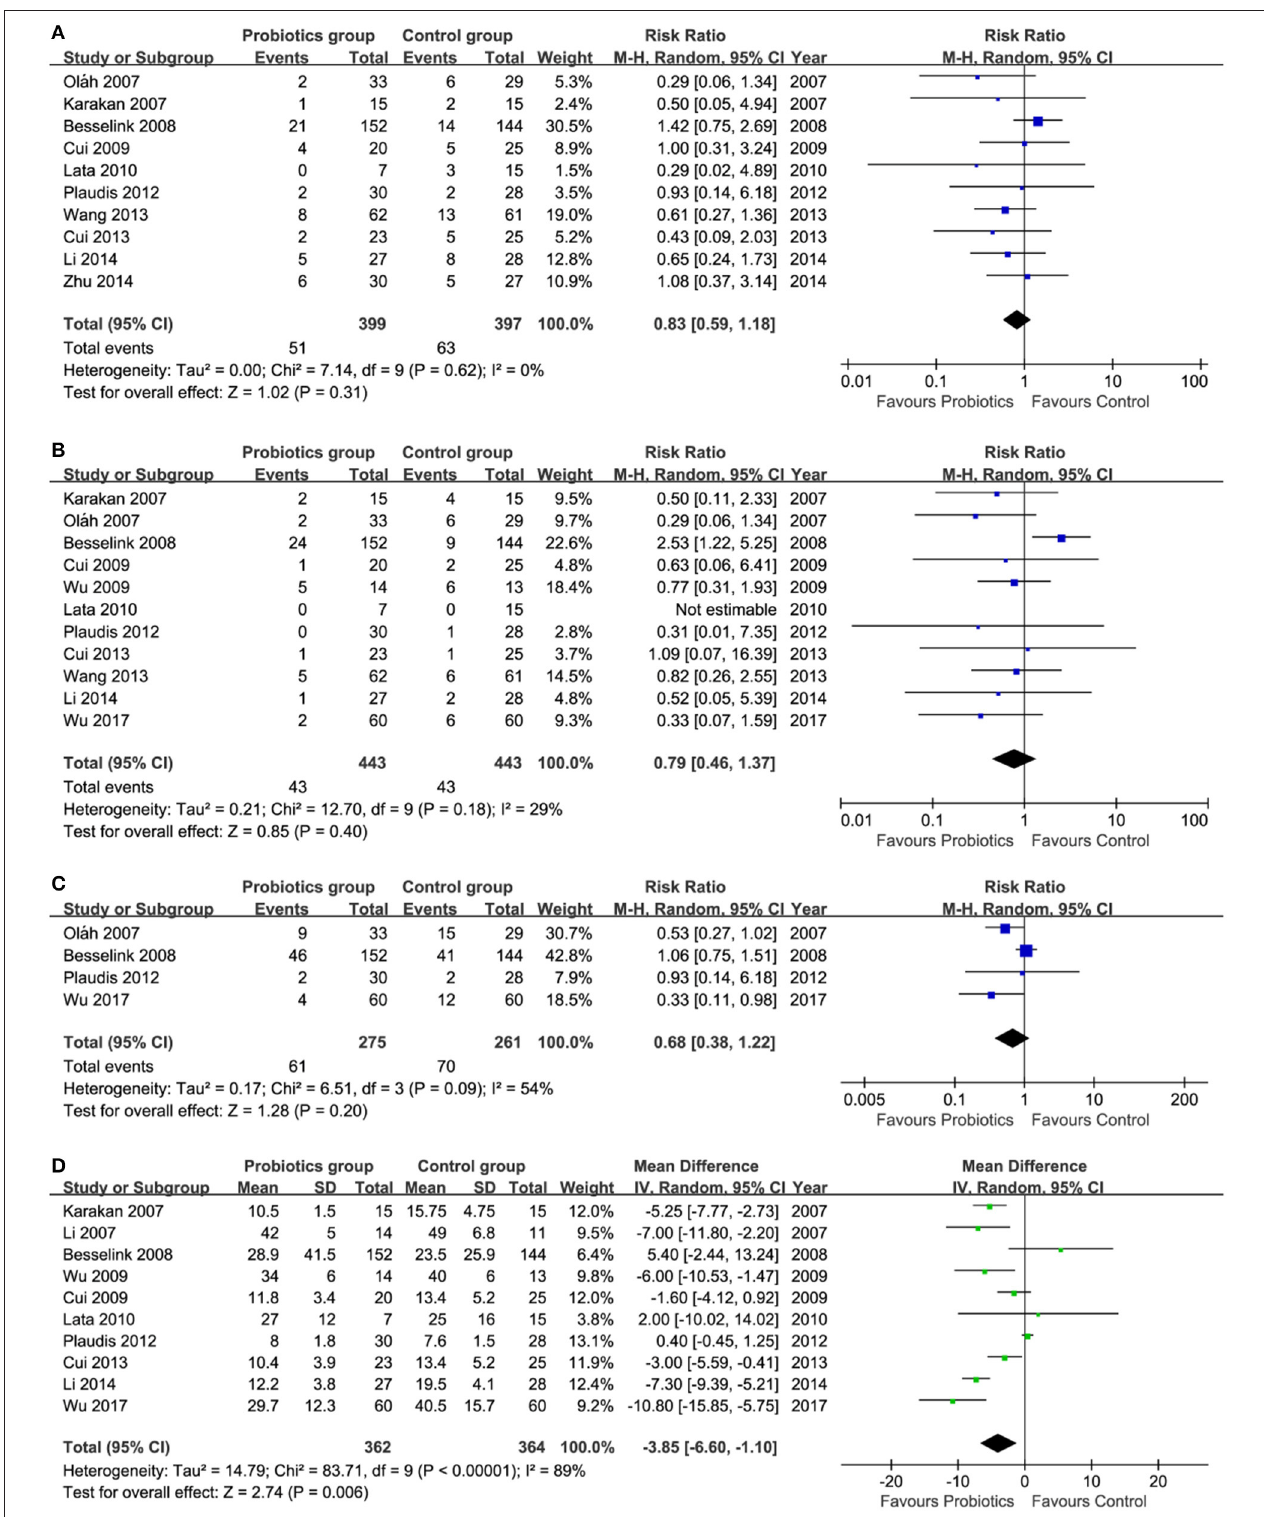
FIGURE 3 | Meta-analysis on primary outcomes. (A) infected pancreatic necrosis, (B) mortality, (C) total infection, and (D) length of hospital stay. CI, Confidence interval; M-H, Mantel-Haenszel.